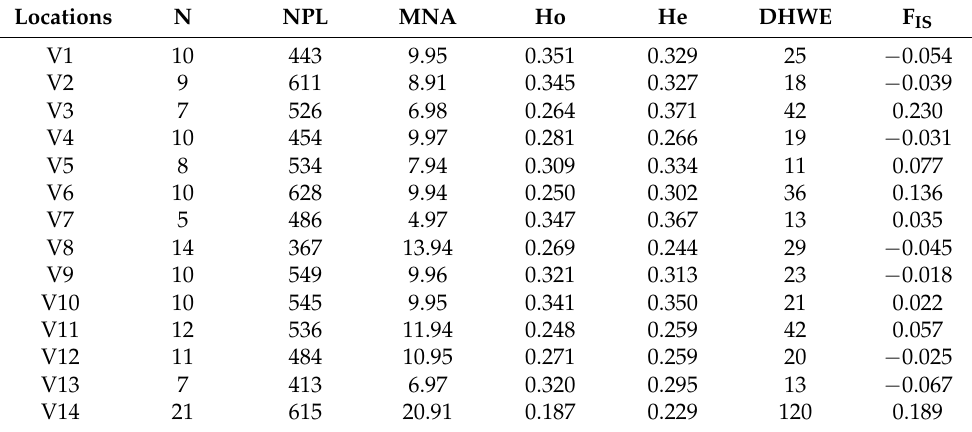
specific F IS . Samples locations and codes are detailed in Table S1.